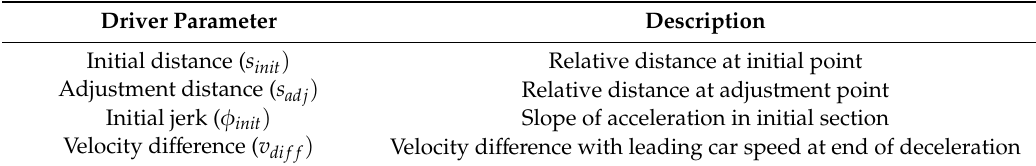
Table 2. Types and descriptions of driver parameters.